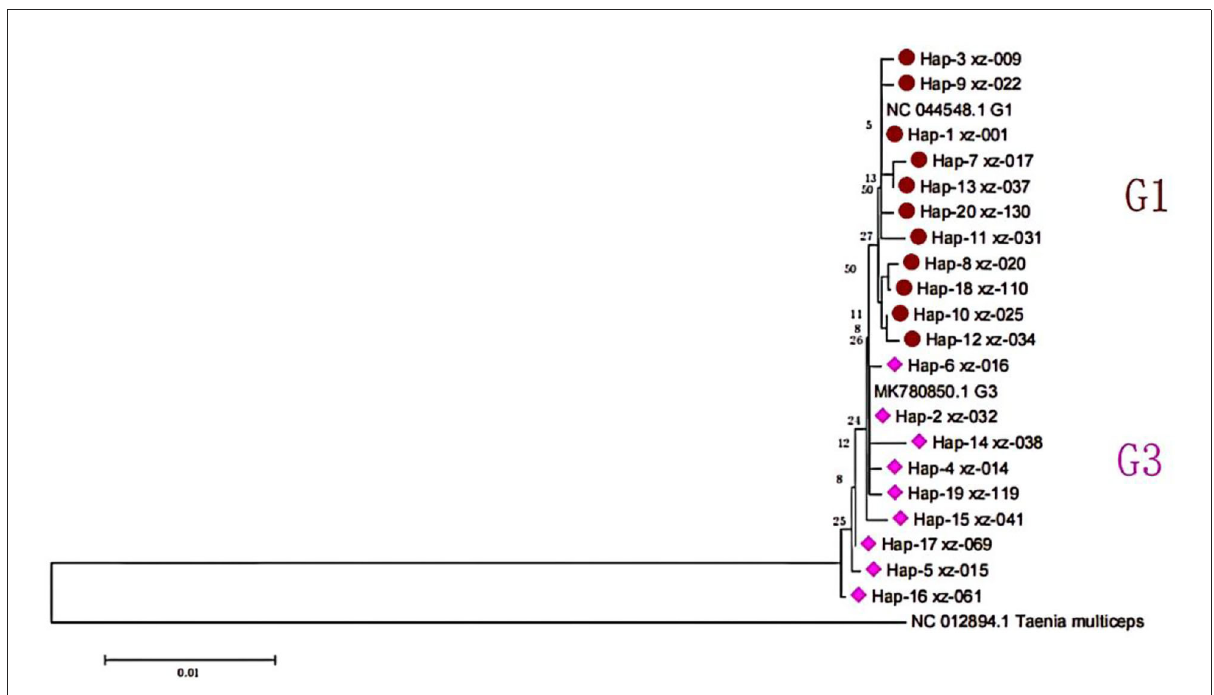
FIGURE2 The phylogeny of E. granulosus s.l. based on cox 1 mitochondrial sequences.